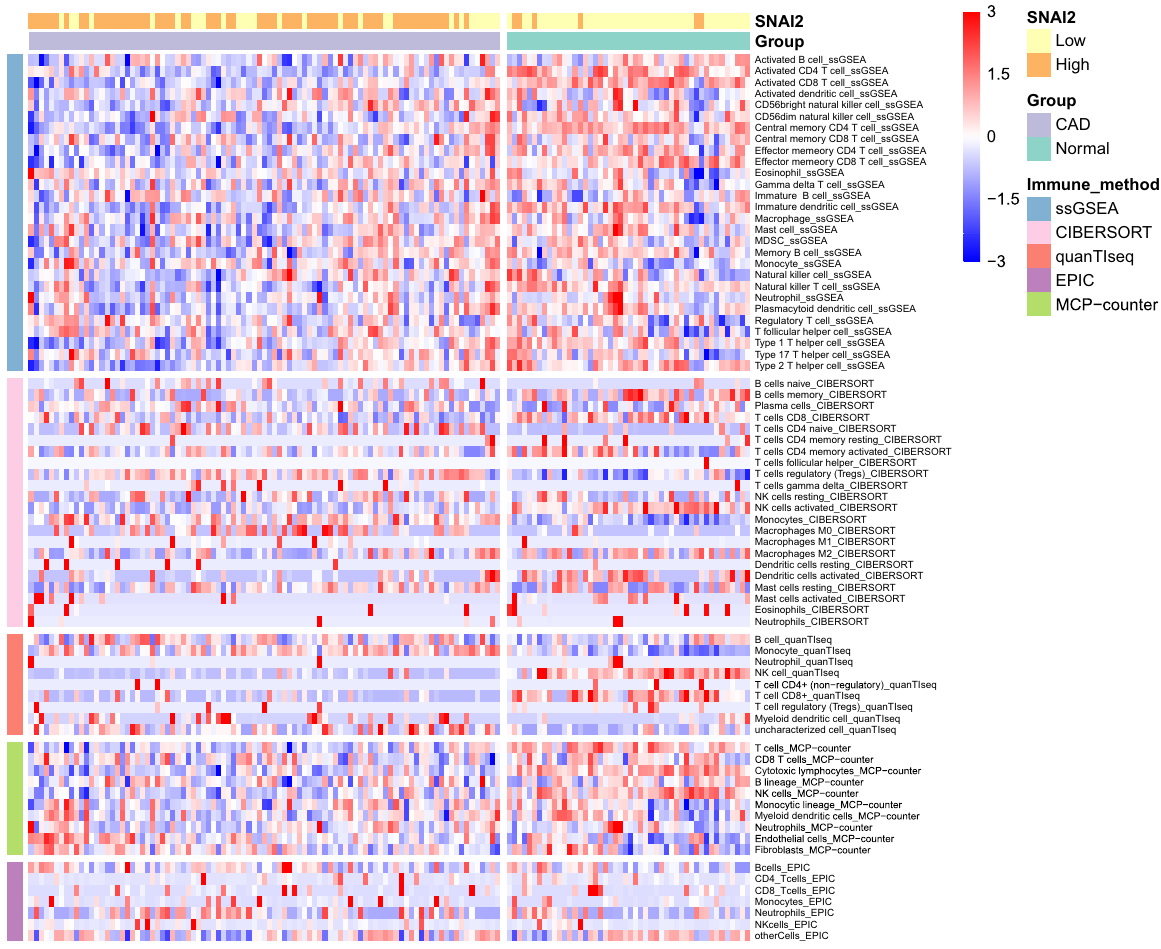
Figure 8: Heatmap for immune cell compositions based on ssGSEA, CIBERSORT, quanTIseq, MCP - counter, and EPIC algorithms among di ff erent